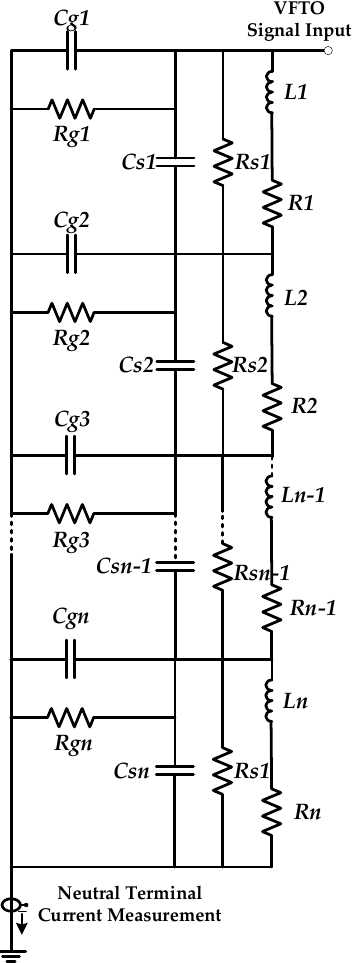
Figure 7. Equivalent circuit model of transformer winding.